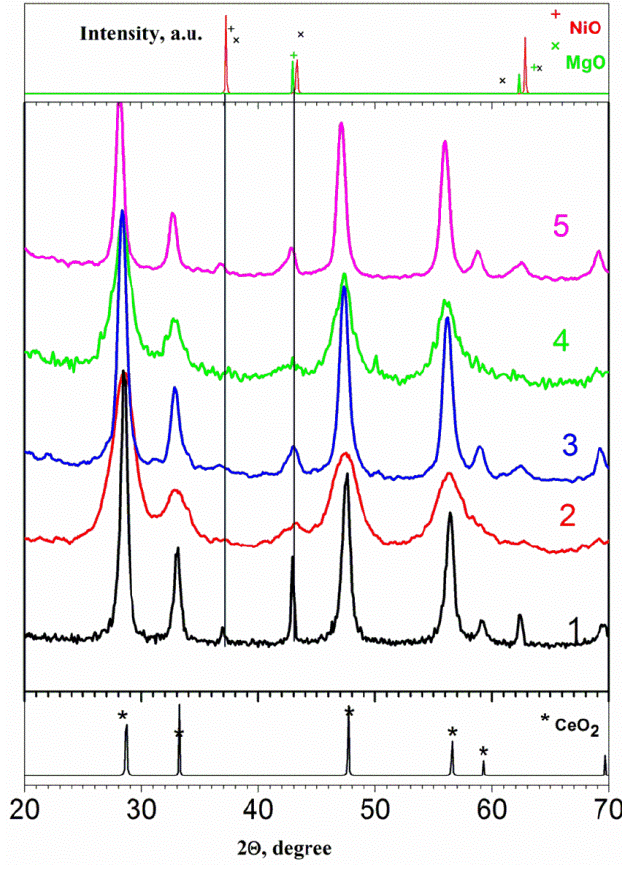
Figure 2. X-ray diffraction patterns of the as-prepared catalysts calcined at 500 °C. 1—Ni/CeMg-C-S-O; 2—Ni/CeMg-A-S-O; 3—Ni/CeMg-A-S-V; 4—Ni-Pd/CeMg-A-S-V; 5—Ni/CeMg-A-P-O.